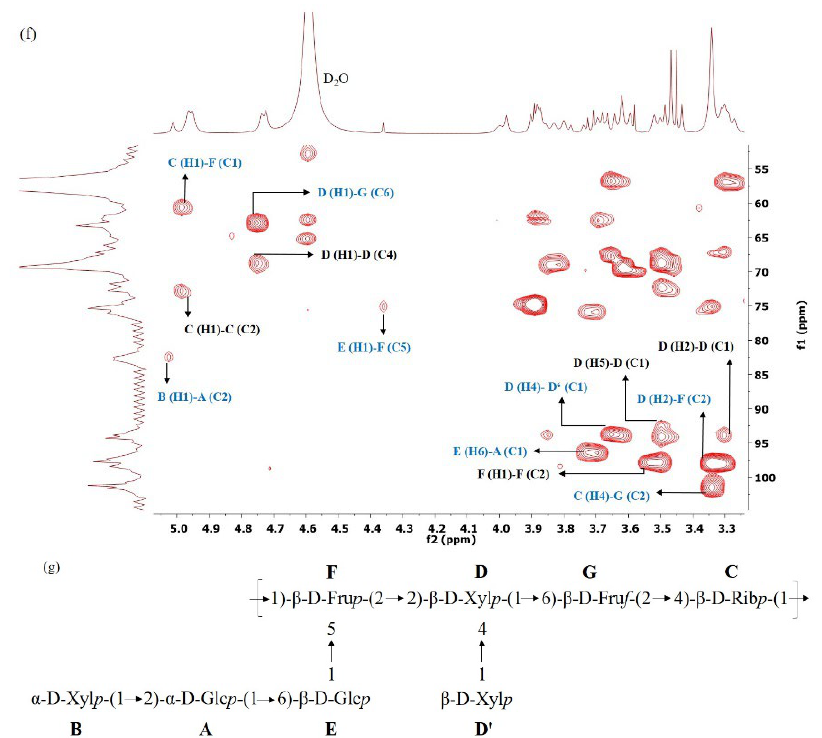
Figure 5. ( a ) 1 H NMR spectrum and ( b ) 13 C NMR spectrum; ( c ) COSY Spectrum; ( d ) TOCSY spectrum; ( e ) HSQC spectrum; ( f ) HMBC spectrum (blue—anomeric to non-anomeric linkages of different sugar residues; black—anomeric linkage of same sugar residue); ( g ) structure of EPS of Virgibacillus dokdonensis VITP14 exopolysaccharide (EPS).